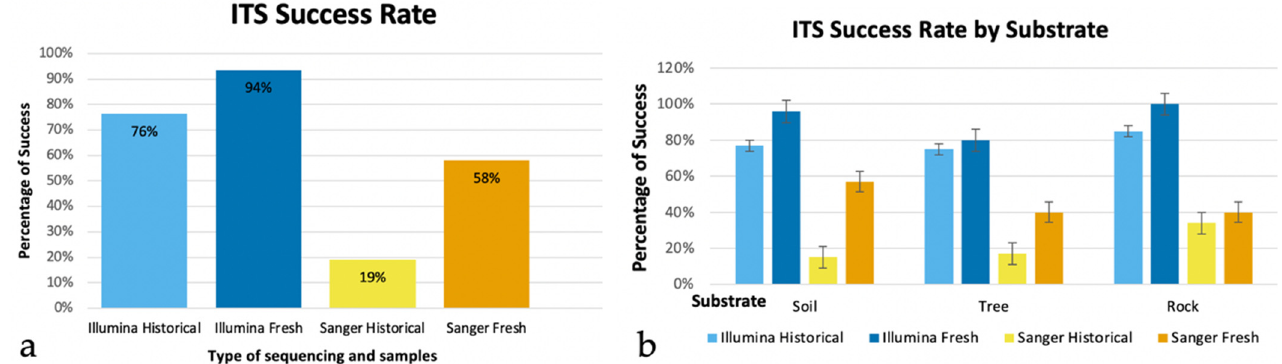
Figure 3. Overall ITS Success Rate in Illumina versus Sanger sequencing with historical and fresh samples ( a ), including a comparison by substrate ( b ). Color pallet proposed by Wong [77].